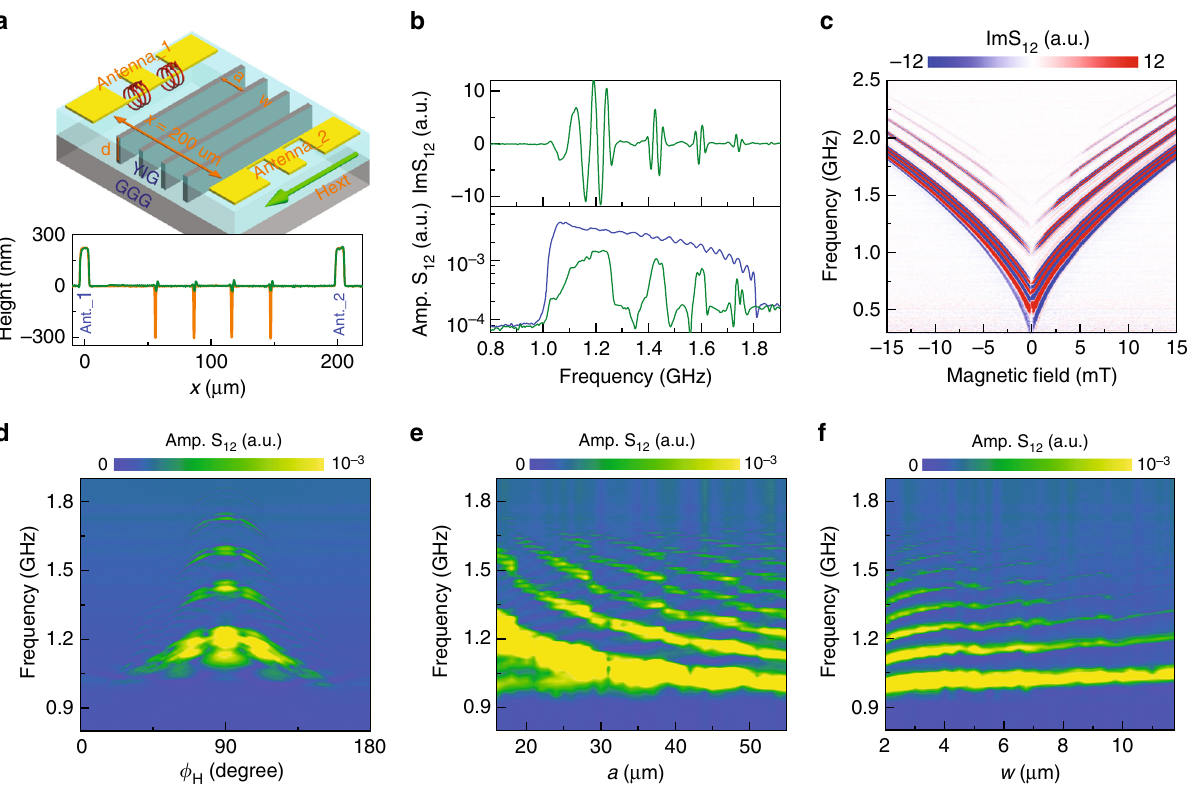
Fig. 2 Spin-wave transmission in nanometer-thick YIG-based magnonic crystals. a Schematic of a one-dimensional magnonic crystal. The crystal consists of physically separated YIG stripes with a thickness of 260 nm and narrow air grooves or grooves that are fi lled by CoFeB. Two 6- μ m-wide microwave antennas are patterned on top of YIG. Their separation is x = 200 μ m. The bottom graph shows height pro fi les for magnonic crystals with air grooves (orange line) and grooves that are fi lled by CoFeB (green line). b Spin-wave transmission spectra (imaginary part and amplitude of S 12 ) for a a 30 w 2.5 CoFeB/YIG magnonic crystal at a magnetic bias fi eld of 5 mT. The reference spectrum (blue line) is recorded on a continuous YIG fi lm. c Imaginary part of S 12 for the same crystal at different magnetic bias fi elds. d Dependence of spin-wave transmission spectra (amplitude of S 12 ) on magnetic fi eld angle in a a 30 w 2.5 CoFeB/YIG crystal. In this graph, 90° corresponds to the excitation of DE spin waves. e , f S 12 amplitude as a function of e lattice constant and f CoFeB stripe width. In e , w = 2.5 μ m. In f , a = 50 μ m. All the data are recorded on magnonic crystals with N = 4 width affects the magnonic band structure less, the ef fi ciency of spin-wave transmission reduces quickly when w becomes large.